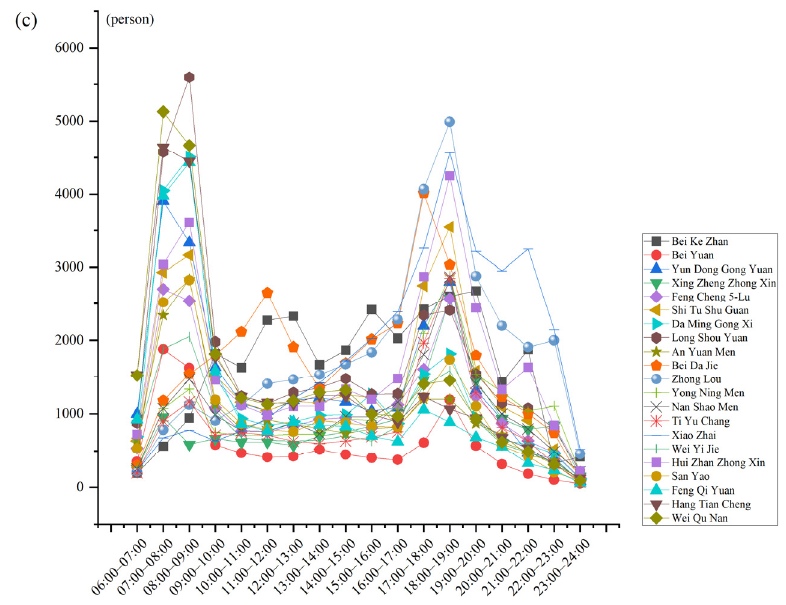
Figure 3. ( a ) Gross floor area of different types of land (GFAs); ( b ) total floor area ratio (FAR); ( c ) hourly passenger flow.